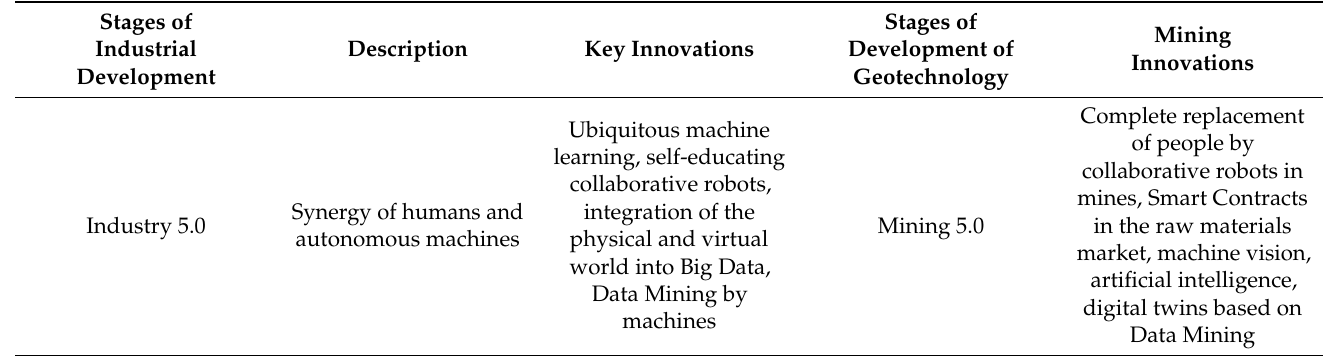
Table 3. Mining 5.0 Innovations (Adapted from Ref.